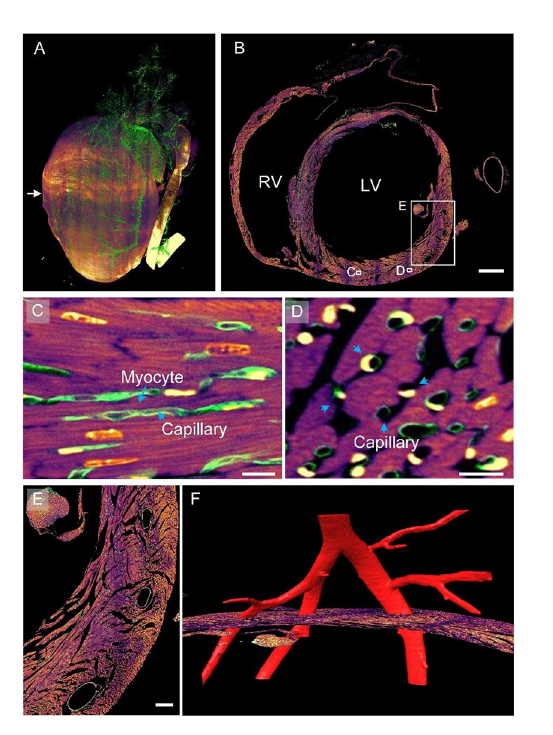
FIGURE4 Myocardial and vascular data of the entire heart within a given mouse. (A) The 3D rendering of heart-wide myocardial and vascular data. The myocardial structure is in fuchsia and the vascular structure in green. (B) A selected axial section in the middle of the heart. LV, left ventricle; RV, right ventricle. Scale bar: 500 µ m. (C,D) Enlarged views of corresponding white boxes in (B) revealing the spatial correlation between cardiomyocytes and capillaries. Scale bars: 10 µ m. (E,F) Enlarged image of the white square in (B) . Scale bar: 100 µ